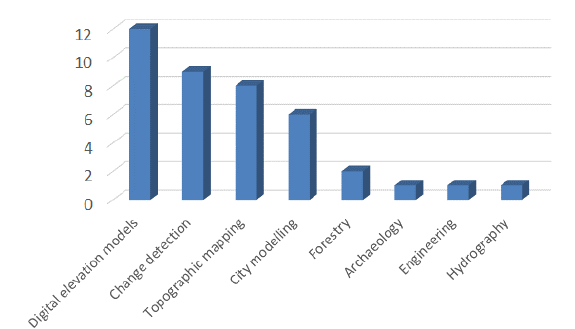
Figure 2. Potential applications of SP/GM lidar as perceived by 20 NMCA respondents.